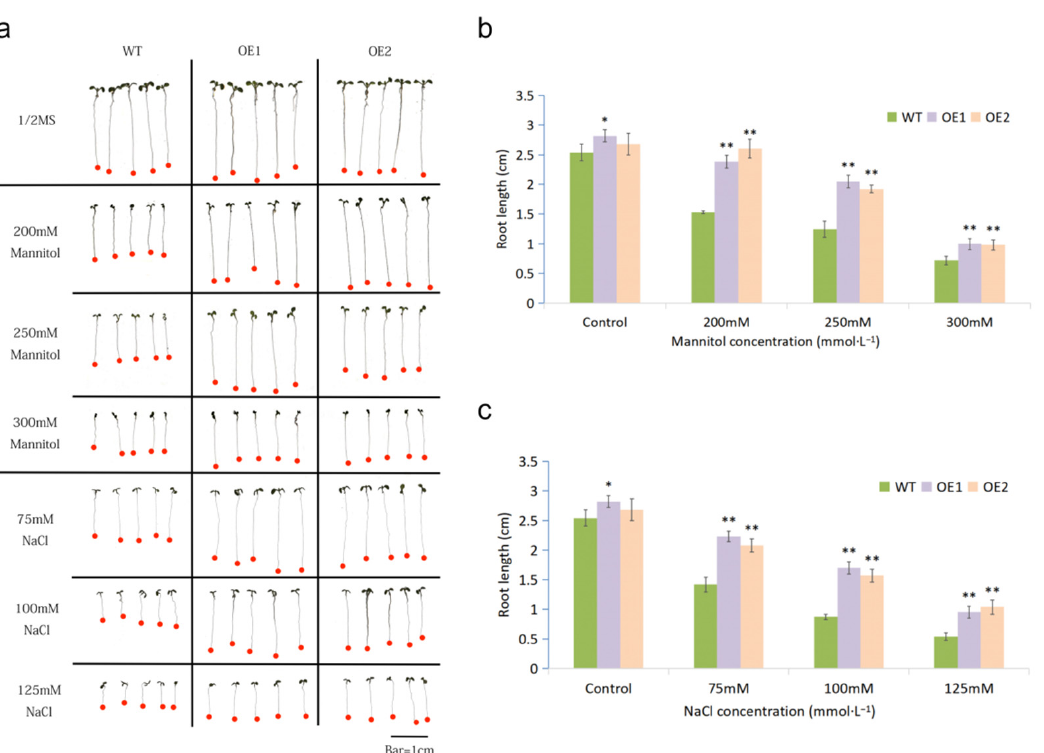
Figure 2. Analysis of drought and salinity tolerance at the seedling stage. ( a ) Morphology of transgenic and WT seedlings grown on 1/2 MS solid medium containing different contents of mannitol and NaCI. ( b,c ) The primary root length of WT and OE lines under conditions with or without mannitol and NaCl, respectively. Data were presented as mean and SD values of three independent experiments. The asterisk indicates a significant difference (* p < 0.05; ** p < 0.01, by Student’s t -test) comparing to WT.